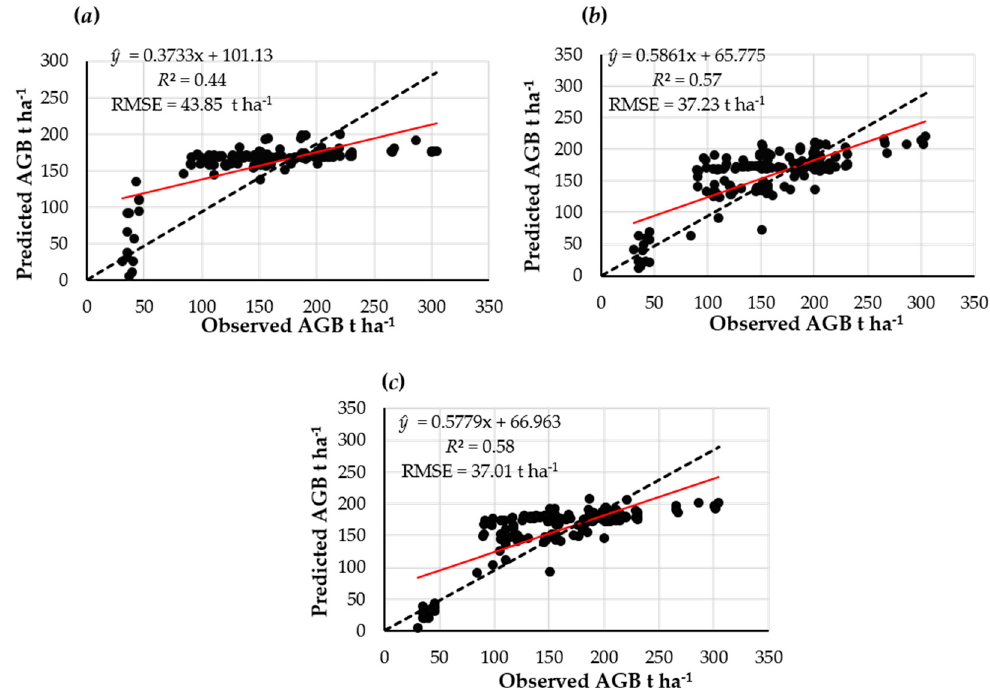
Figure 2. Observed vs predicted aboveground biomass (AGB) using an MLR approach for ( a ) image spectral information (ISI), ( b ) vegetation indices (VIs), and ( c ) ISI + VIs.